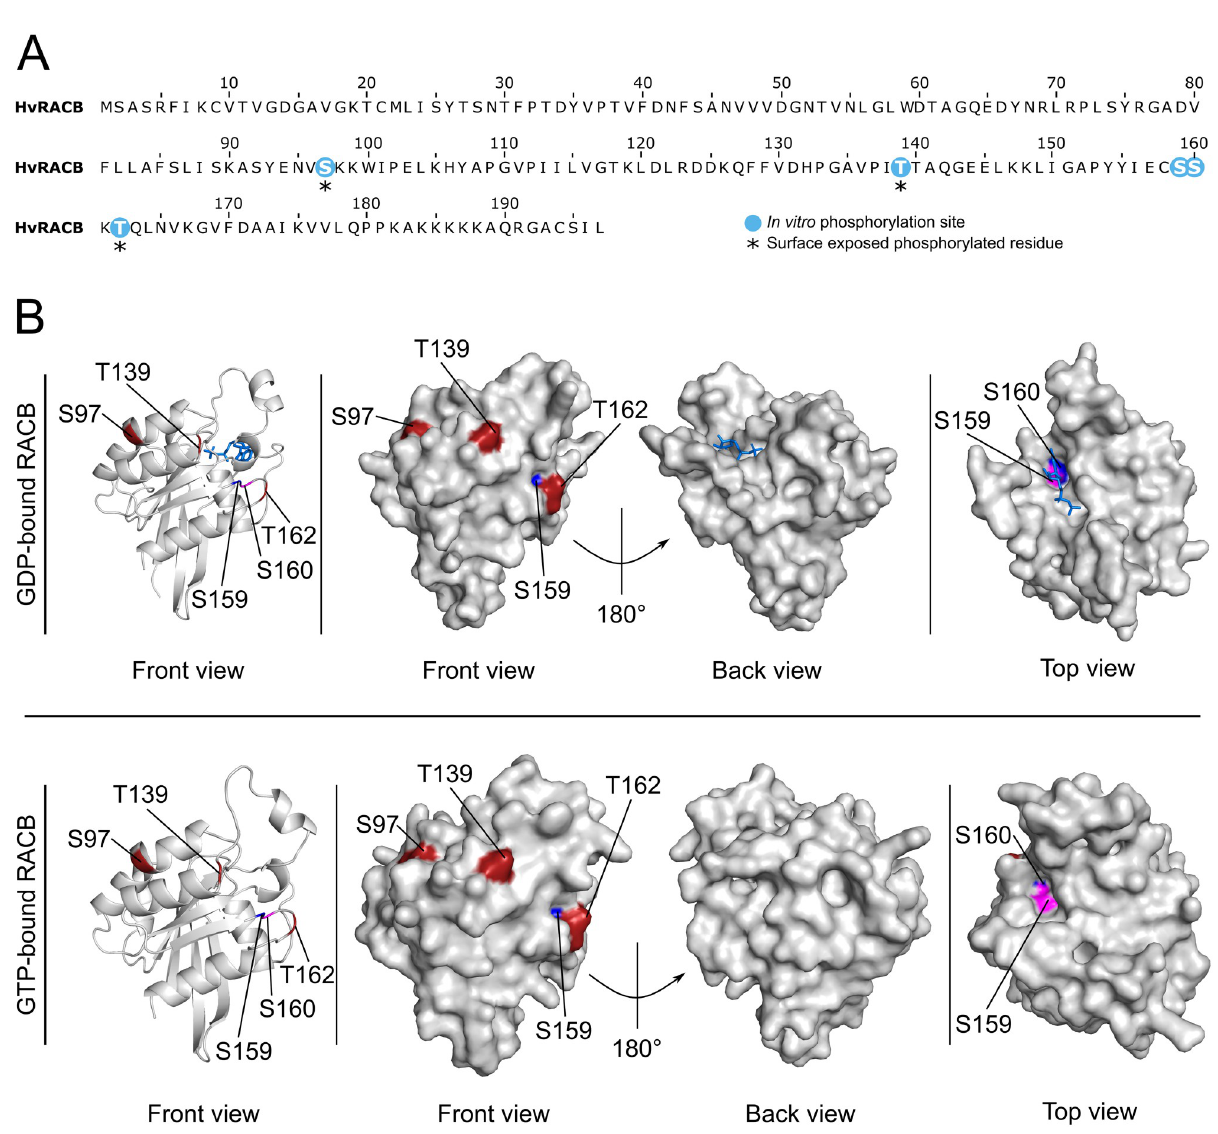
Fig 2. Surface-exposure of CA-RACB in vitro phosphosites. (A) Phosphorylation sites of CA-RACB are shown in blue or, when phosphorylated and predicted as surface-exposed, residues are additionally highlighted by asterisks. In vitro phosphorylation sites of RACB were identified by mass spectrometry after in vitro co-incubation of CA-RACB and RBK1. (B) Upper panel: the model of GDP-bound WT RACB (amino acids 1–178 from 197 total) was built with GDP-bound At ROP4 as template (PDB entry: 2NTY.1 [38]). Lower panel: GTP-bound WT RACB (amino acids 7–178 from 197 total) was modelled using Hs RAC1 associated with GNP (phosphoaminophosphonic acid-guanylate ester, a non-hydrolysable GTP-analog) as template (PDB entry: 3TH5.1 [39]). Phosphorylated surface-exposed residues are highlighted in red, GDP as ligand in blue. Only S97, T139 and T162 are surface-exposed, S159 (pink) and S160 (blue) are not clearly exposed to the surface. Putative RACB folds were assembled by homology-modelling using SWISS-MODEL and achieved GMQE (global model quality estimate) scores of 0.75 for GDP-RACB and 0.66 for GTP-RACB, and QMEAN DisCo (qualitative model energy analysis with consensus-based distance constraint [40]) scores of 0.82 ± 0.07 and 0.80 ± 0.07, respectively. Surface structure (front, back and top view) and cartoon (front view) illustrations were modelled in PyMOL [41]. within the peptide sequence (S1 Table), both residues were treated as possible but alternative phosphosites. Using computational modelling of the RACB protein structure based on the protein models of GDP-bound At ROP4 and GTP-analog-bound Hs RAC1, we suggest that S97, T139 and T162 are surface-exposed in RACB, whereas this is less clear for S159 and S160 (Fig 2B).